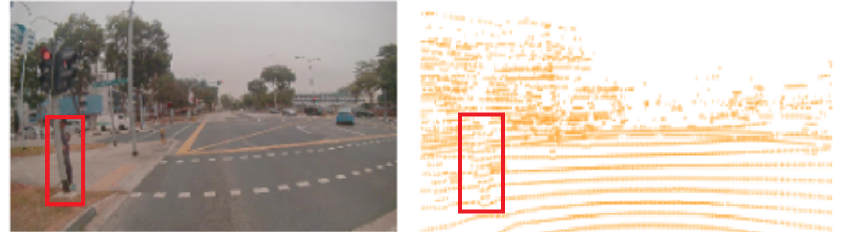
Figure 7. Sensor fusion between LiDAR and camera using image point projection: The left is a bounding box detection of a pedestrian, and the right is the image point projection of the